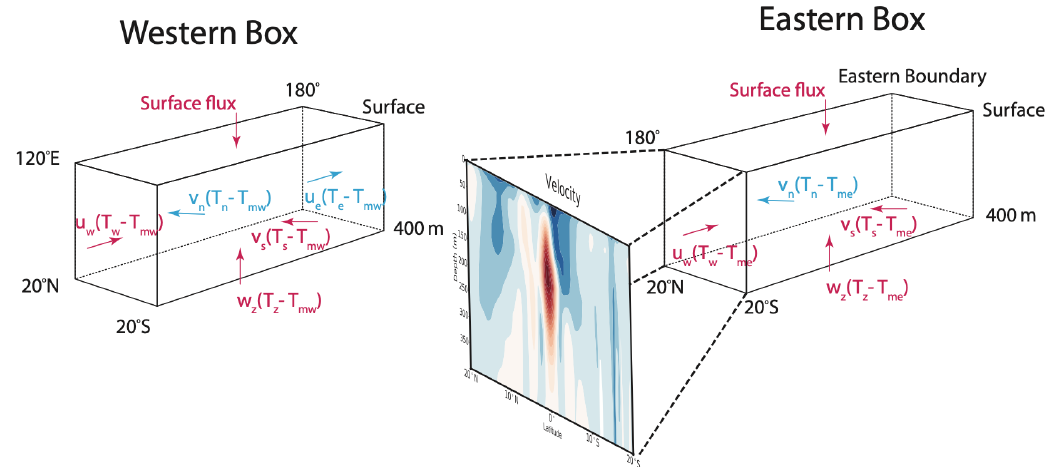
Figure 5. The two-box regions for the heat budget analysis, with the western box (Wbox) and the eastern box (Ebox) shown over the tropical Pacific. The western box is from 120 ◦ E–180 ◦ , 20 ◦ S–20 ◦ N, and 0–400m, and the eastern box is from 180 ◦ –eastern boundary, 20 ◦ S–20 ◦ N, and 0–400m. All variables are a function of space and time. T is potential temperature; u , v , and w are the velocity components in the ˆ x , ˆ y , and ˆ z directions, respectively. Subscripts w, e, s, n, and z represent the western, eastern, southern, northern, and bottom boundaries of the boxes, respectively. T mw and T me represent the volume mean temperature in the Wbox and the Ebox, respectively. The velocity field transect across 180 ◦ between Wbox and Ebox is shown by the shaded field, where a positive value represents eastward flow. Detailed defined current systems based on the velocity field are shown in Fig.